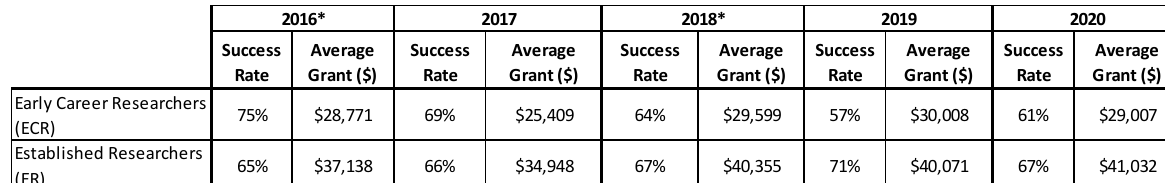
Overall Comparative Statistics Discovery Grants Competitions,